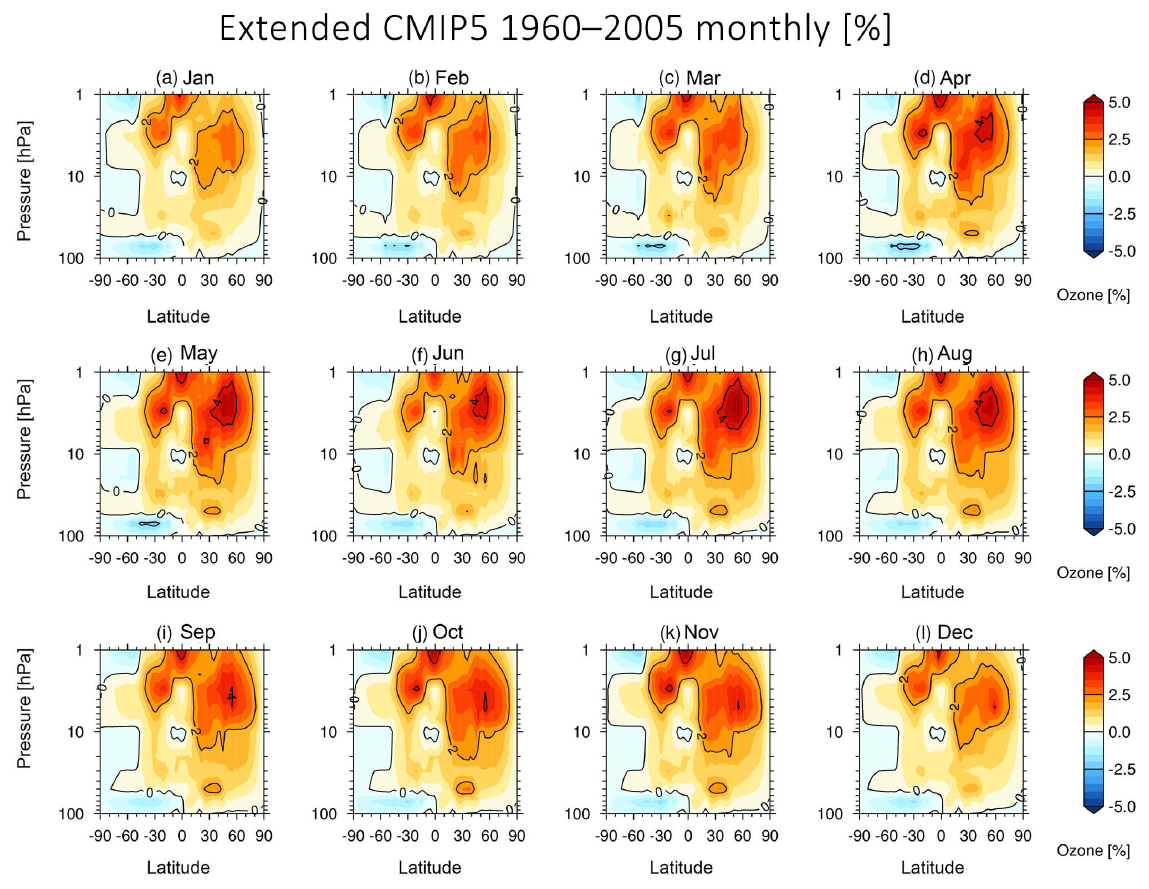
Figure 7. Monthly mean percent (%) ozone anomalies per 130SFU for (a) January to (l) December in the Extended CMIP5 ozone database. The solid contours denote 2%